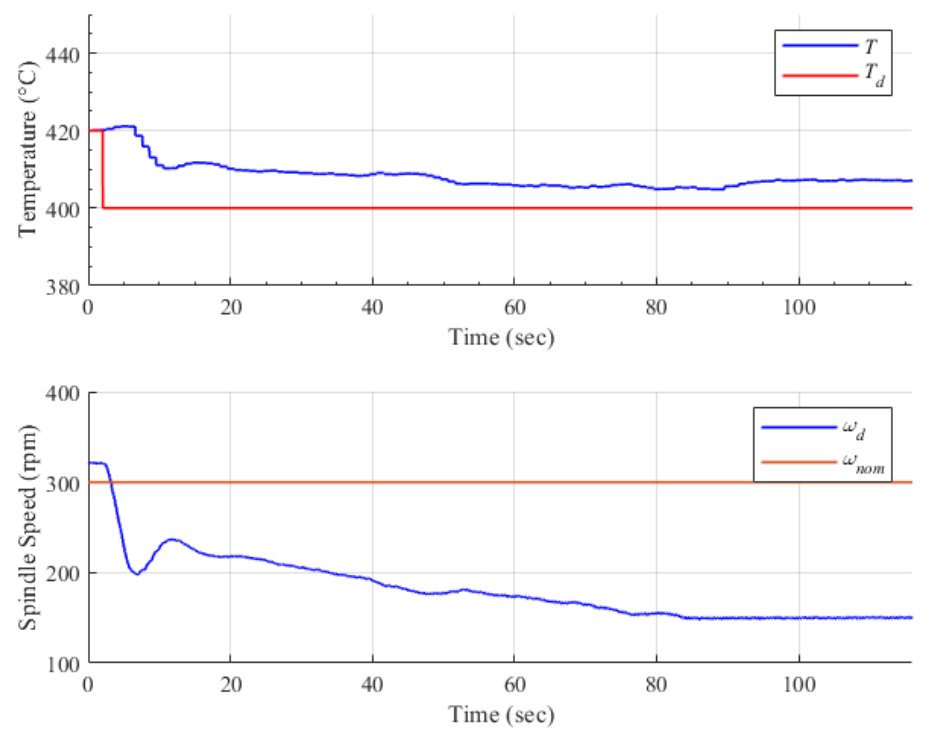
Figure 12. Protocol E. ( Top ) The desired versus measured temperature. The desired temperature was decreased at t ≈ 5 s. A maximum error of 11.3 ◦ C occurs at t ≈ 170 s. ( Bottom ) The desired and nominal spindle speeds.